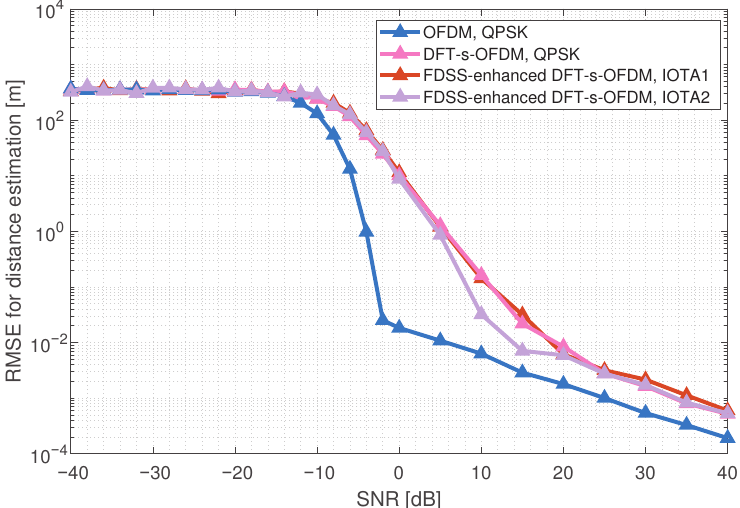
Figure 11. Sensing performance of FDSS-enhanced DFT-s-OFDM with